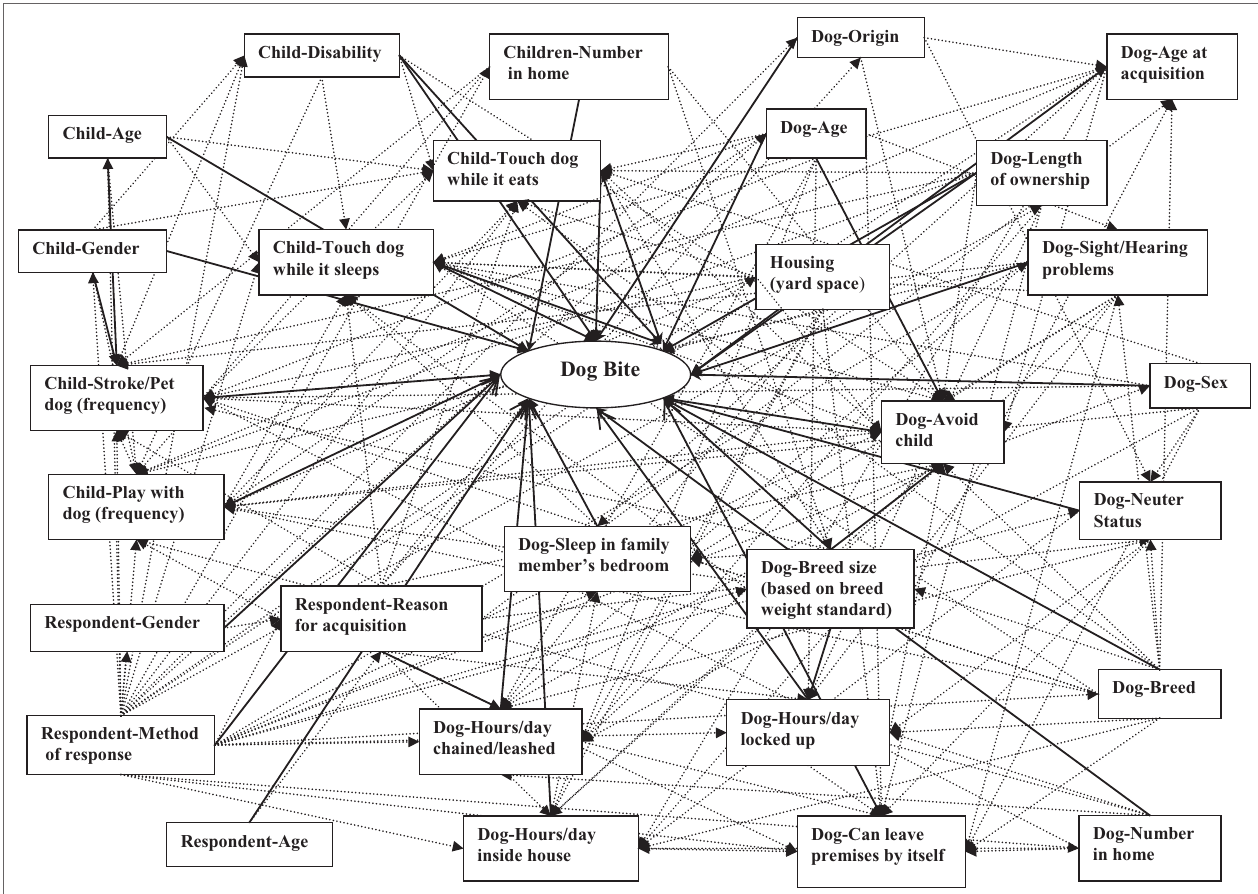
FigUre 1 | Master directed acyclic graph showing hypothesized causal web of dog bites. Solid lines represent hypothesized causal relationships between exposures and dog bites. Dotted lines represent hypothesized causal relationships between